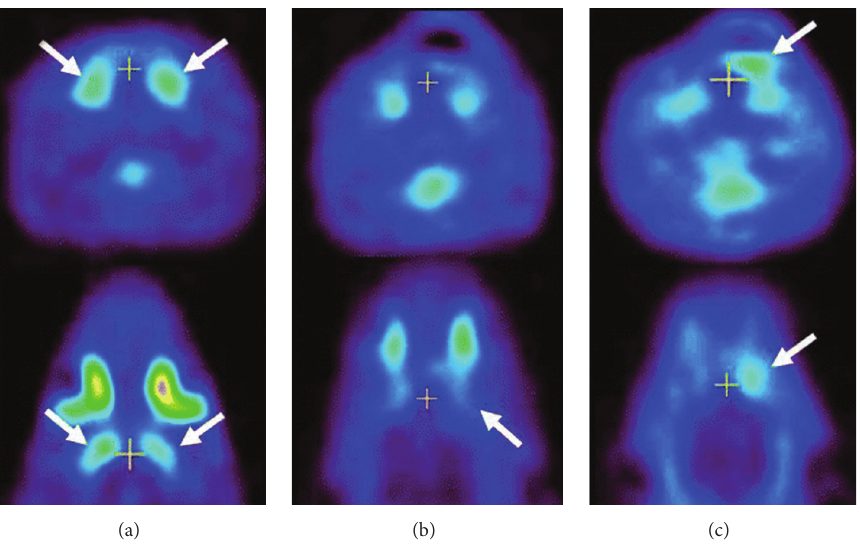
Figure 6: Typical examples of 11 C-NMSP micro-PET imaging in various conditions. Coronal and axial sections of rat brain are shown. White cross markers in the coronal and axial sections indicate the same position in a scan. (a) Typical image of 11 C-NMSP micro-PET in normal rat brain showing high 11 C-NMSP accumulation in striatum. (b) L/N ratio of 11 C-NMSP decreased after traumatic brain injury. (c) High accumulation of 11 C-NMSP indicated the existence of transplanted DRD2-positive NSCs